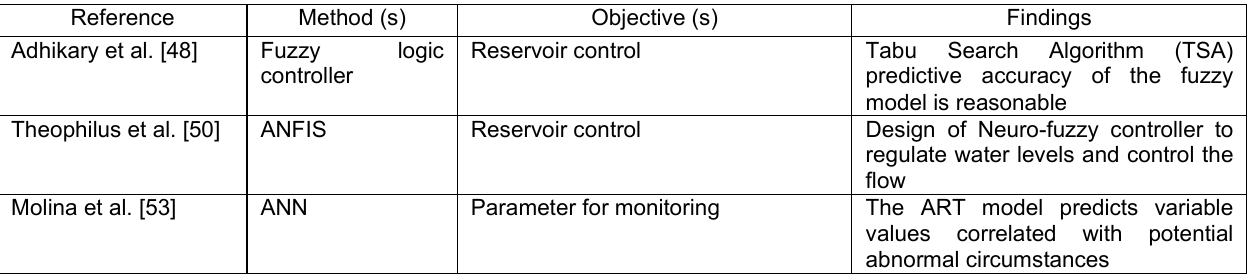
Table 4. Summary of the applications of AI in monitoring and control of hydropower